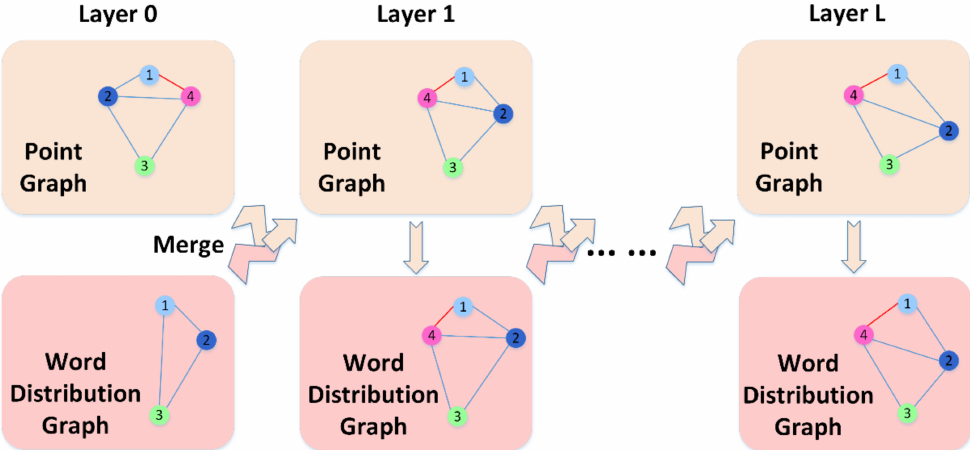
Figure 4. Cycle calculation process of the